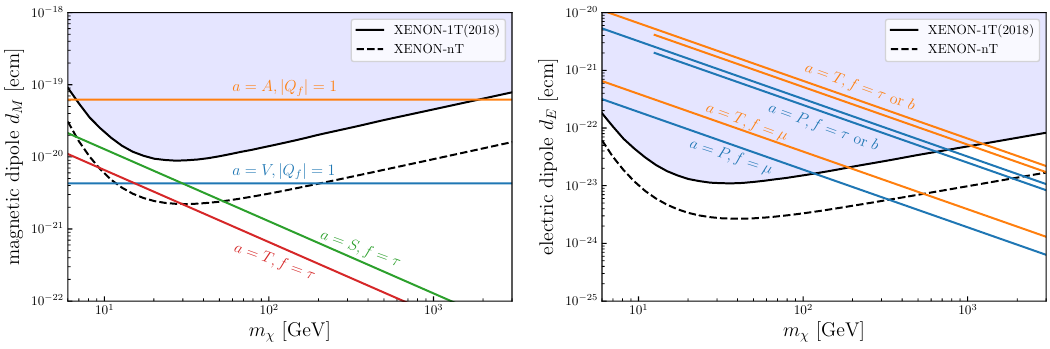
Figure 4 . The loop-induced magnetic dipole d M (left panel) and electric dipole d E compared with the XENON-1T [10] limit and the future XENON-nT [58] sensitivity. The theoretical expectations of d M and d E are computed according to eqs. (4.1)–(4.4). Dipoles for other fermions than the ones